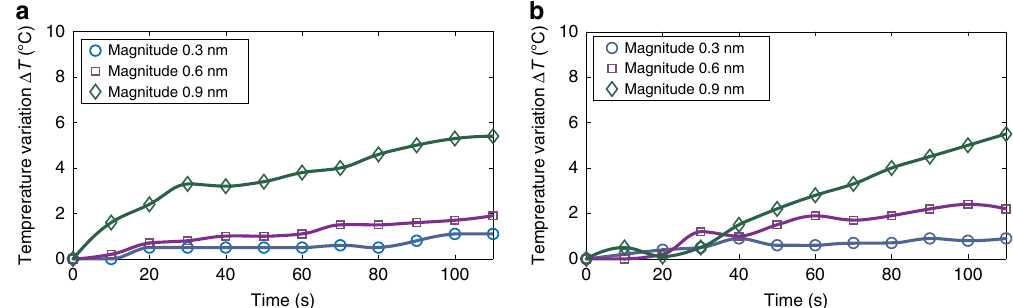
Fig. 6 Temperature variation induced by acoustical tweezers. The measurements were performed with an infrared camera Testo 871 for different acoustic displacement magnitude. a Measurement at the top of the glass slide. b Measurement inside a glycerol layer deposited on top of the glass slide and acting as a perfectly absorbing layer. The data represented on these graphs represent single measurements. These measurements were conducted twice with similar